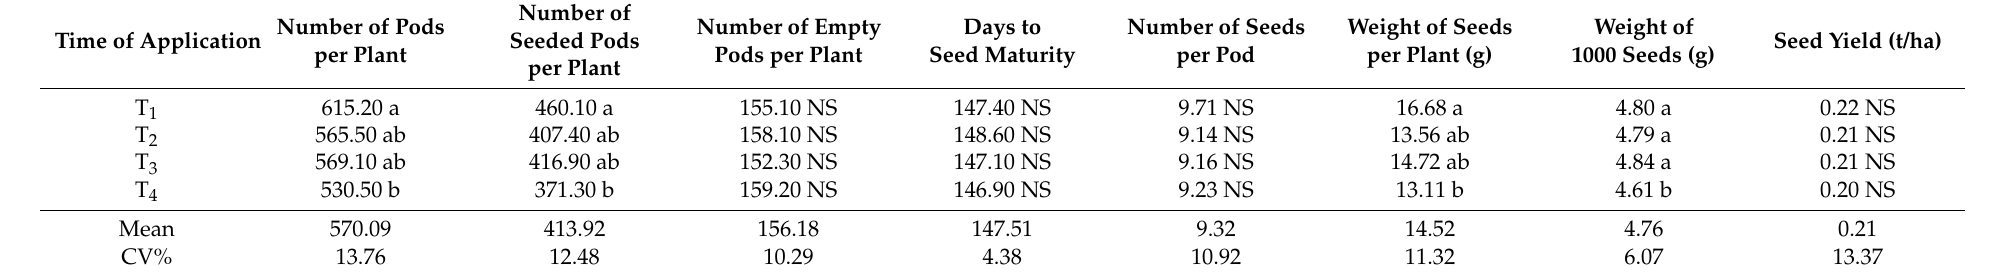
Table 5. The main effect of time of application on seed yield and related agronomic traits in BU